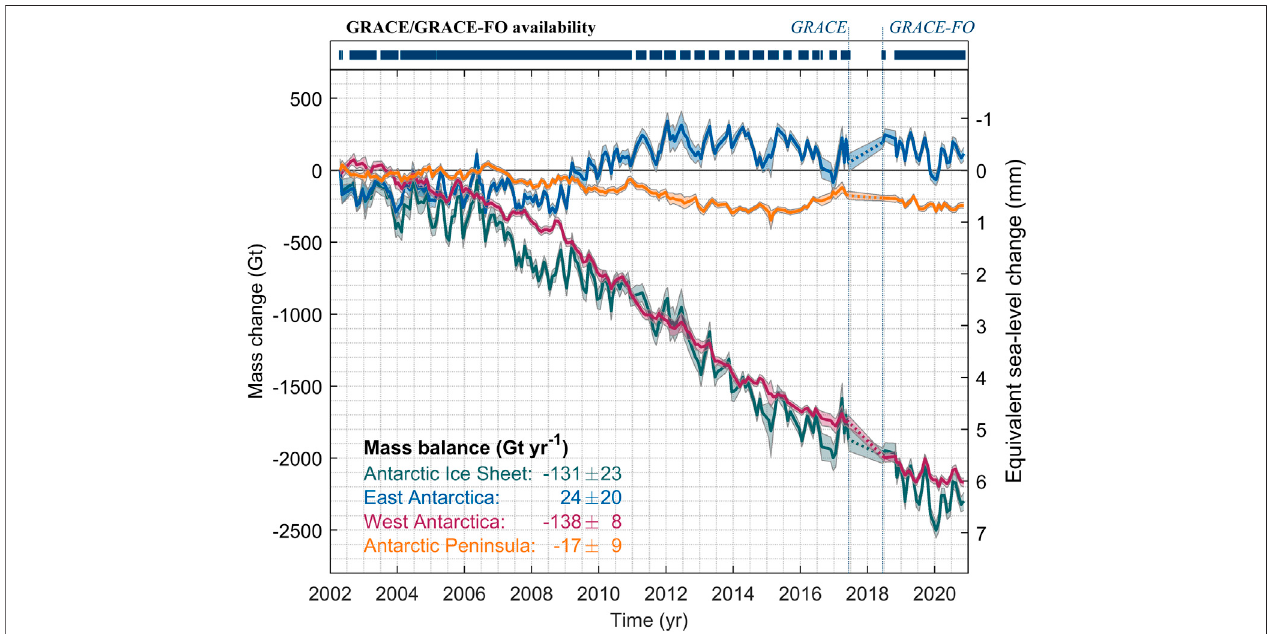
FIGURE 2 | Mass change of the Antarctic Ice Sheet from April 2002 to September 2020. Time series of mass change from the GRACE and GRACE-FO missions, M ( t ) , for the entire Antarctic Ice Sheet (green) and its division into East Antarctica (blue), West Antarctica (red) and the Antarctic Peninsula (yellow). The vertical lines indicate the end of the GRACE and begin of the GRACE-FO monthly data availability (June 2017 and July 2018, respectively). Shadings represent 1- σ uncertainties. Equivalent sea-level contribution (right axis) is approximated as 1 mm sea-level rise for 360 Gt of ice mass loss.